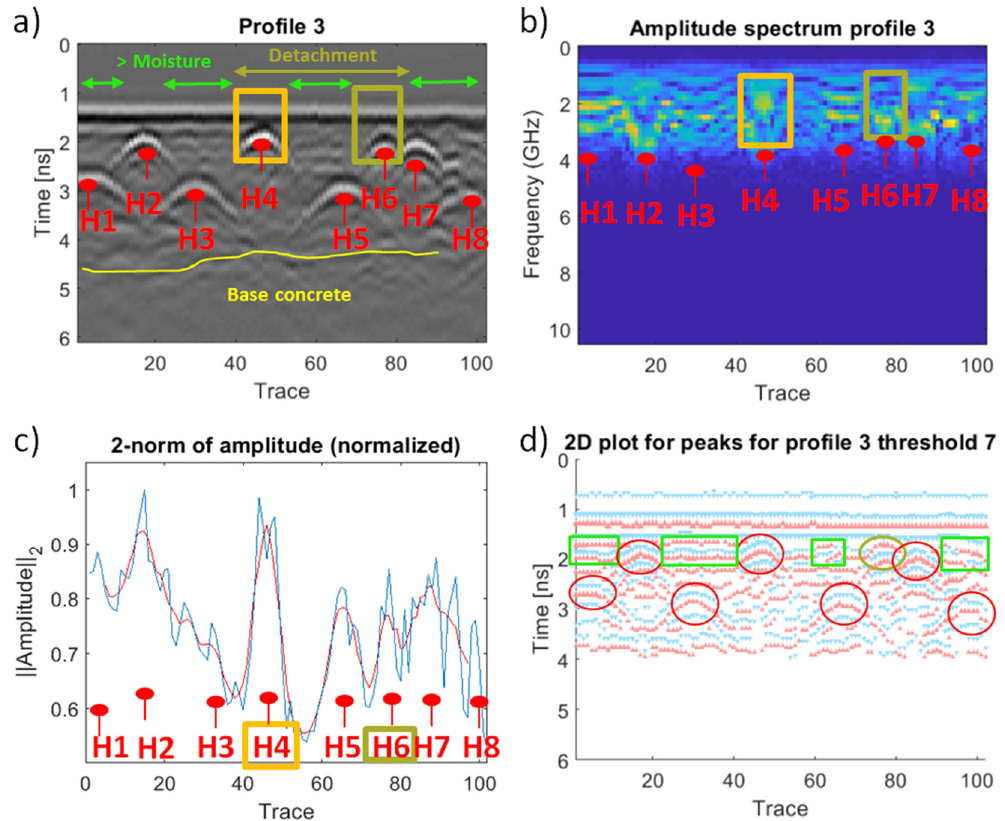
Figure 7. Graphics obtained for GPR profile 3 and interpretation. The olive-green rectangles in ( a – c ) represent voids or delamination and orange rectangles indicate open-air rebars. The red circles in ( d ) represent a positive polarity of the reflections produced by the rebars, while the olive-green circles represent a negative signal polarity due to the presence of voids and lawn green rectangles correspond to moist areas.